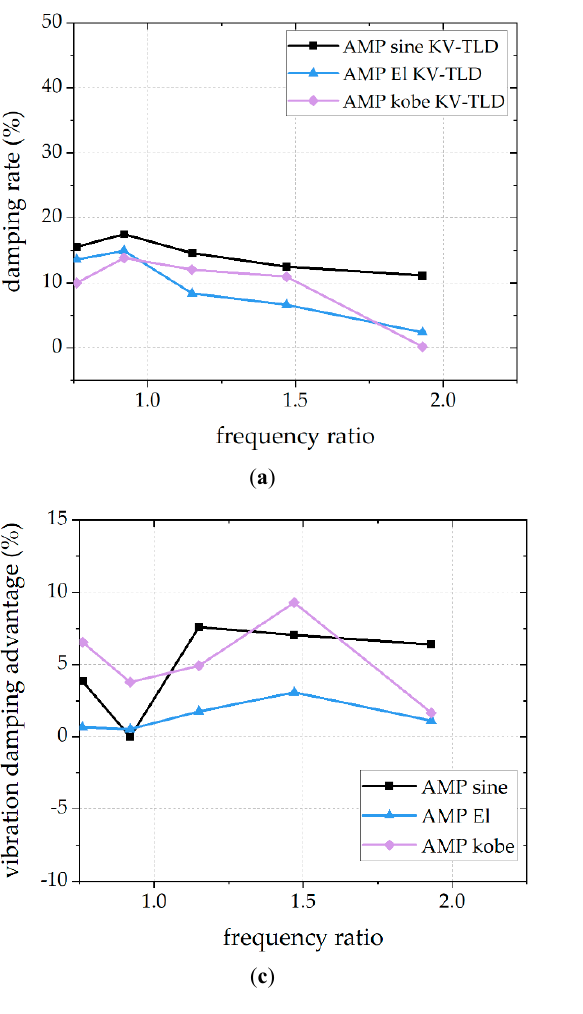
Figure 6. Frequency ratio analysis: mass ratio (2%): ( a ) damping rate (AMP); ( b ) damping rate (RMS); ( c ) vibration damping advantage (AMP); ( d ) vibration damping advantage (RMS).